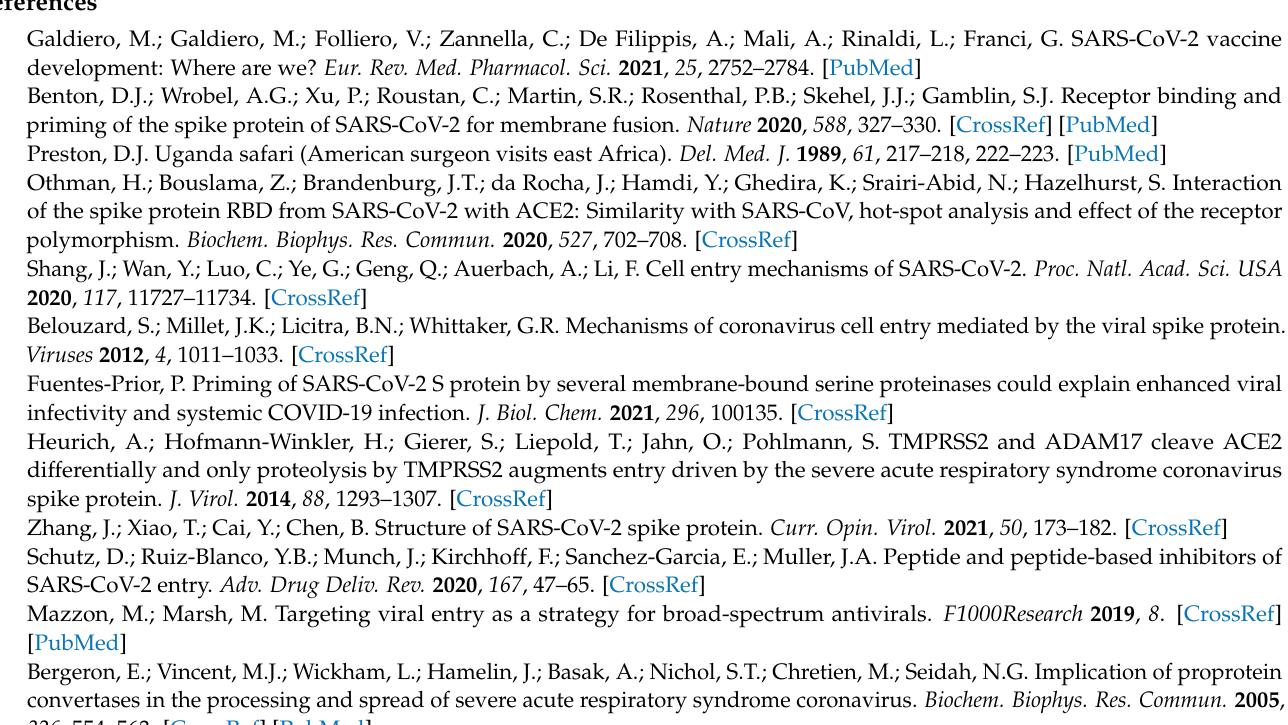
ture; Figure S3: Molecular simulation of tripeptides interacting with surface proteins of different human viruses; Figure S4: Molecular simulation of the peptide AAA interacting with SARS-CoV-2 spike protein; Figure S5: Antiviral activity of tripeptides against HCoV-229E; Figure S6: BLI inter- action analysis with TLH and VFI; Figure S7: BLI interaction analysis with AAA and FIV; Table S1: Cytotoxicity and antiviral activity of tripeptides against representatives of enveloped and